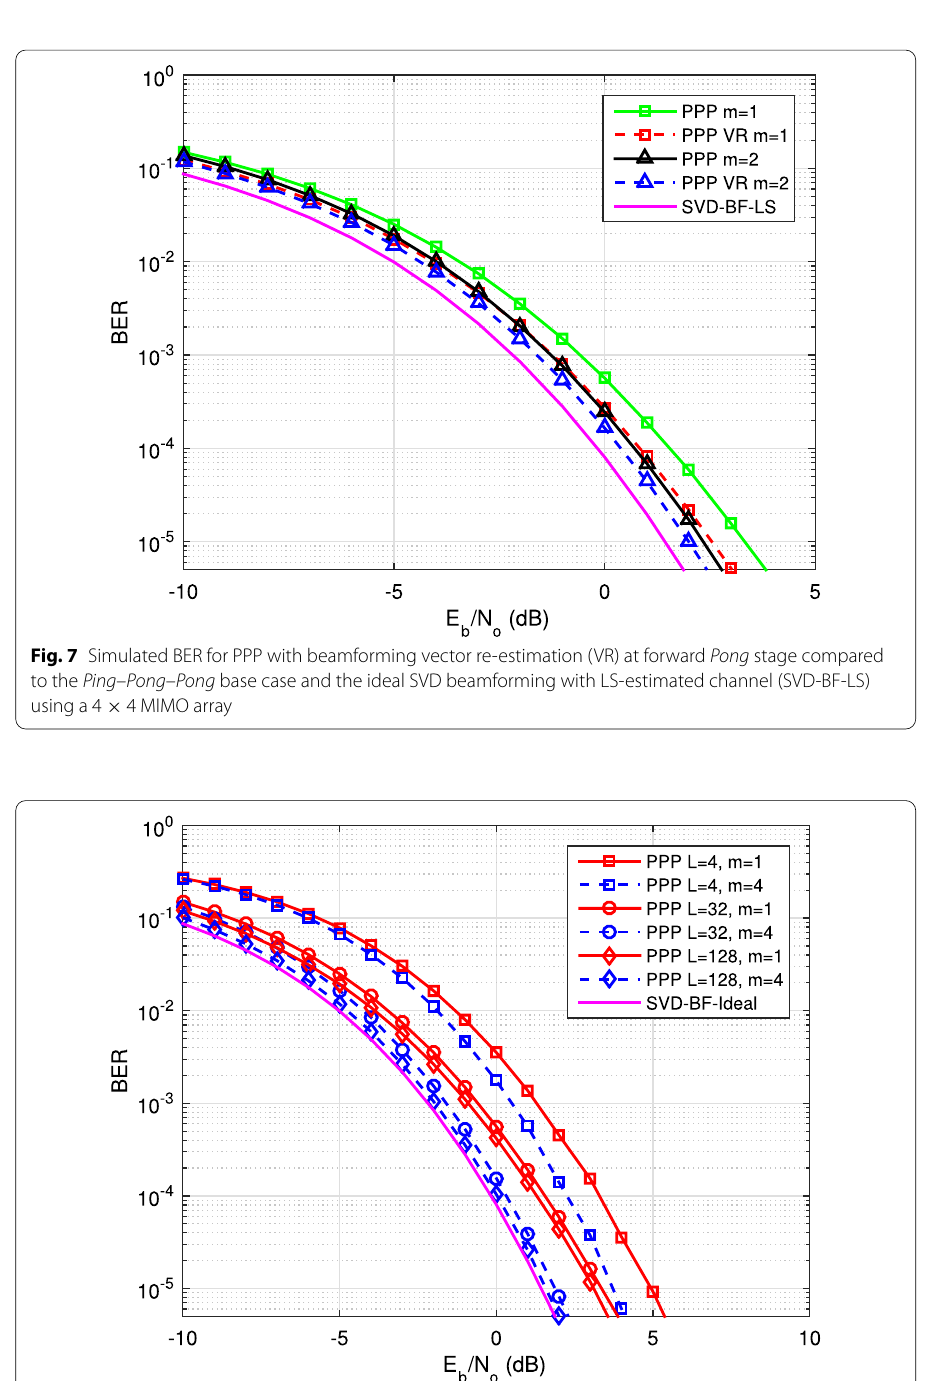
L 2 L 2 L 2 4 , L 1 32 and L 1 128 symbols for channel estimation, = = = = = = 4 iterations of the PIA using a 4 4 MIMO array. They are compared to the = ×